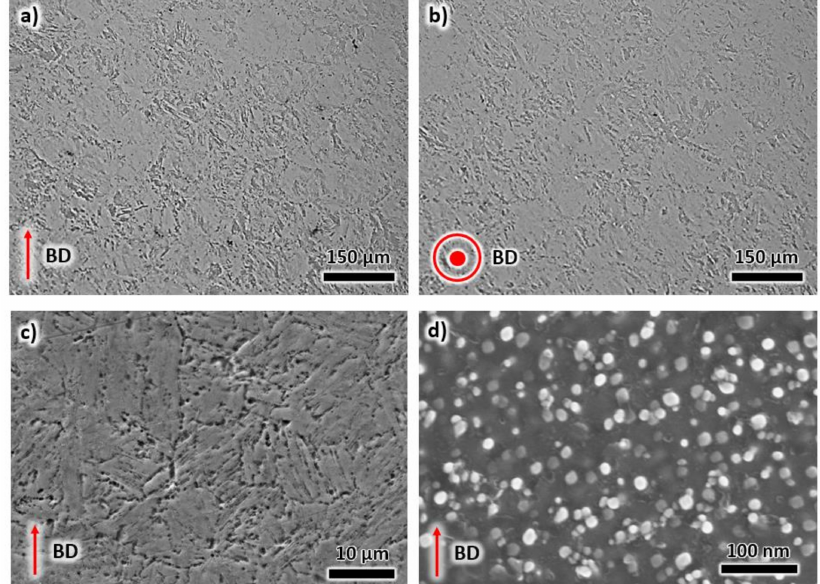
Figure 7. Optical microstructures of the heat-treated sample taken from ( a ) building direction, and ( b ) transverse direction. SEM images of the same sample using ( c ) low magnification and ( d ) high magnification